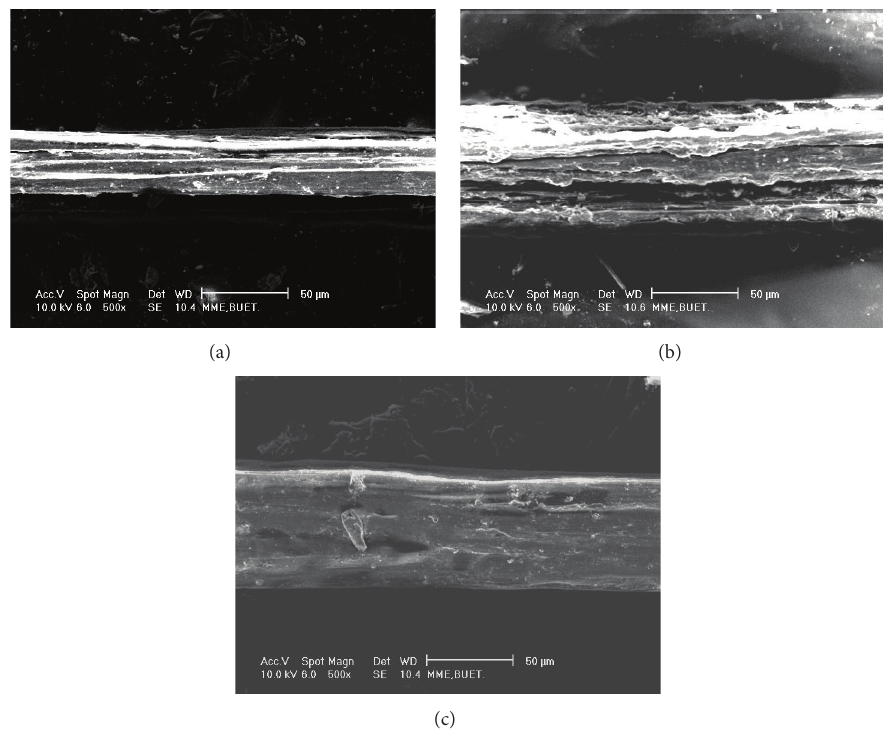
Figure 2: Surface morphology of (a) top, (b) middle, and (c) cutting portions of raw jute fiber.